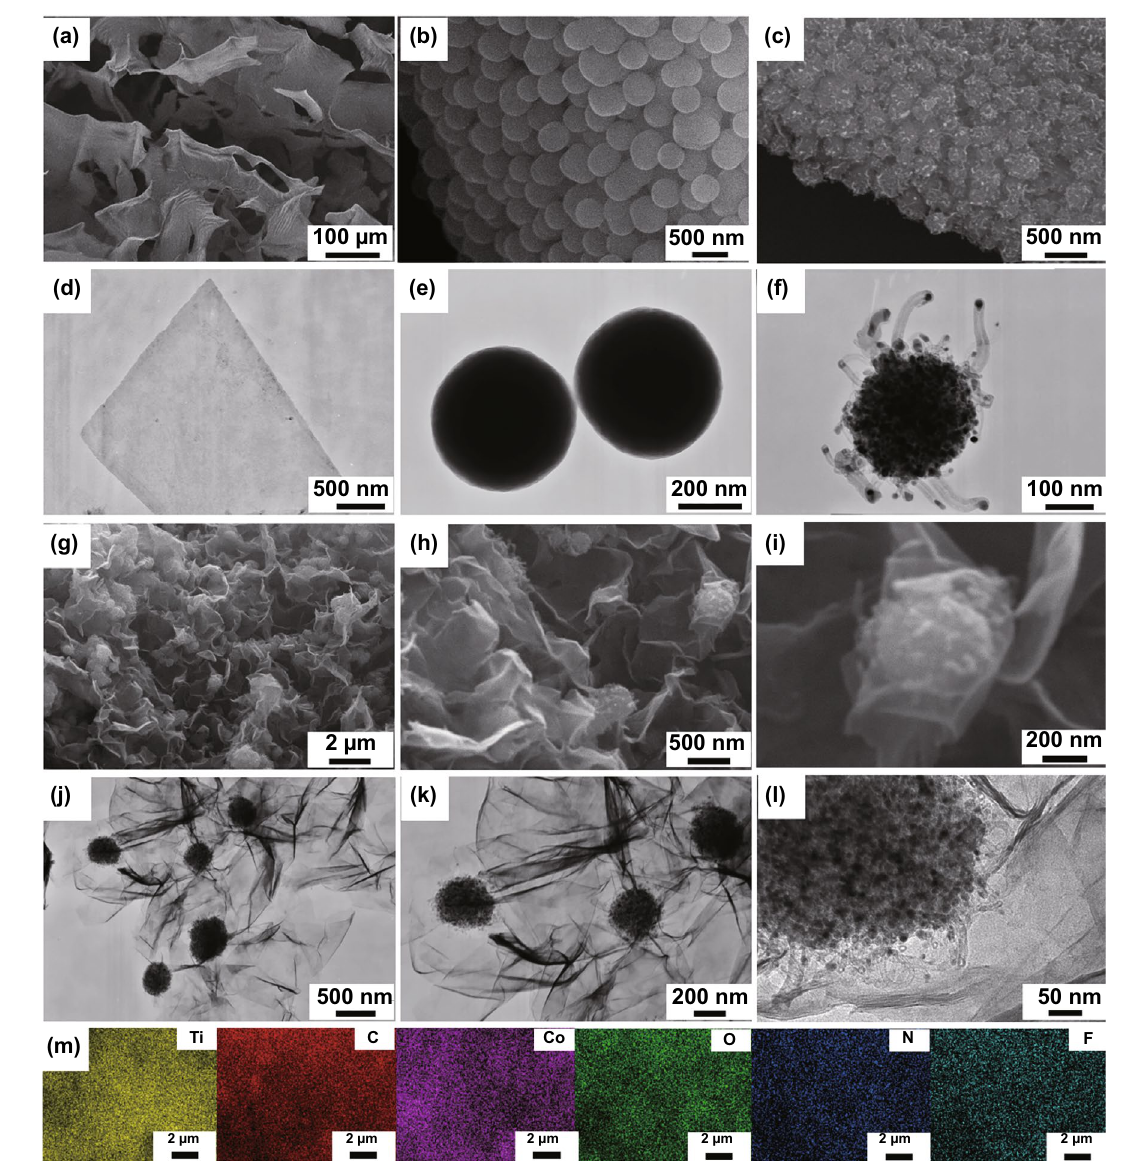
Fig. 2 SEM images of a Ti 3 C 2 T x , b Co-MOFs, c CNTs/Co and g–i Ti 3 C 2 T x /CNTs/Co. TEM images of d Ti 3 C 2 T x , e Co-MOFs, f CNTs/Co, and j‑l